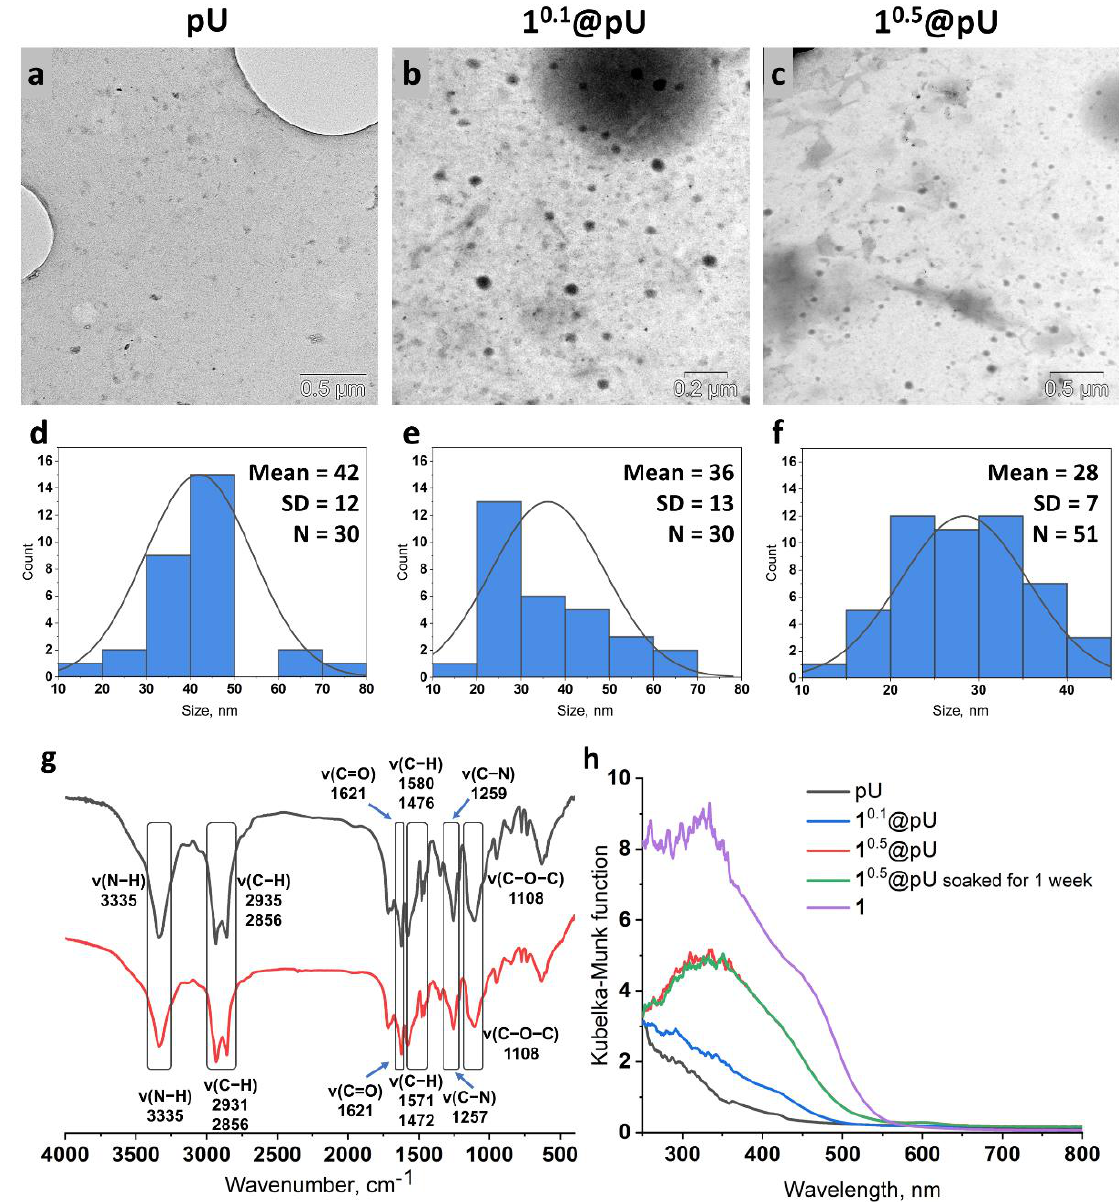
Figure 2. ( a – c ) TEM pictures of pU (scale 0.5 µm), 1 0.1 @pU (scale 0.2 µm), and 1 0.5 @pU (scale 0.5 µm);